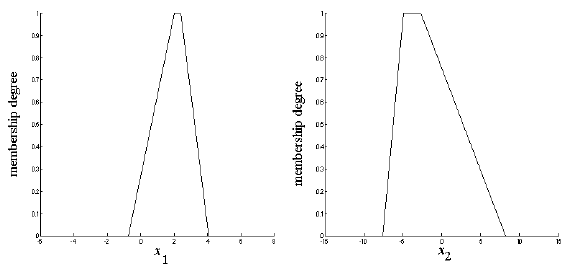
Fig. 6. The trapezoidal FSs corresponding to the cluster of Fig. 3, associated to the class G t